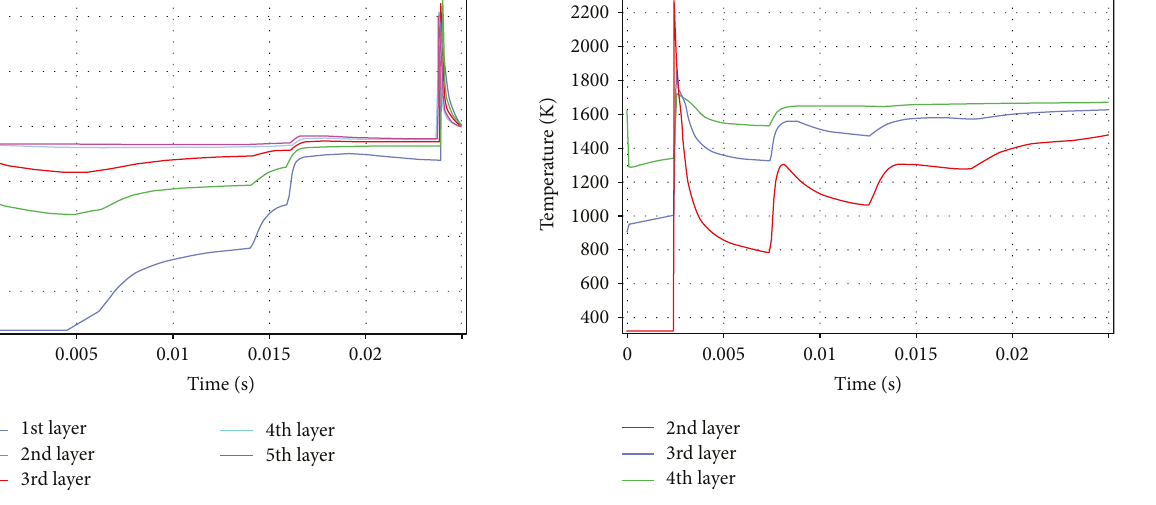
Figure 14: The highest temperature variation curves of fi ve